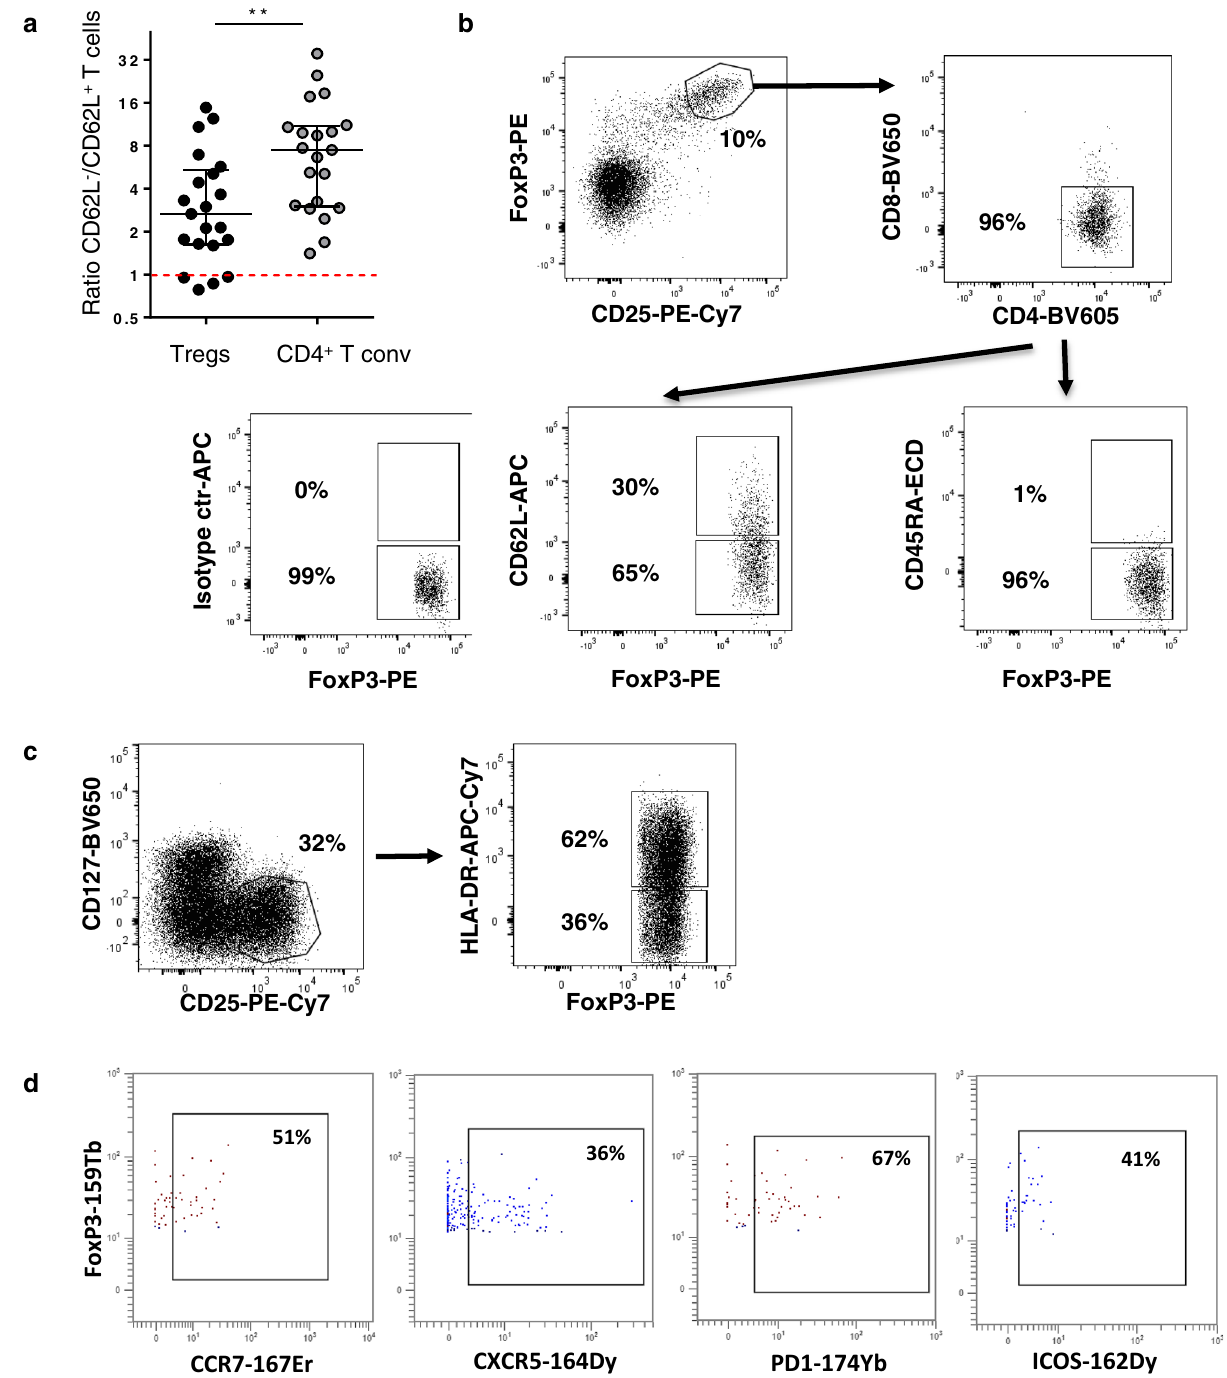
Fig. 2 Phenotype of Tregs in NSCLC. a Ratio of non-TLS to TLS CD3 + CD25 bright FoxP3 bright Tregs and CD4 + Tconv was determined according to the differential expression of CD62L ( n = 21 patients). Data are represented by median with interquartile range. Wilcoxon – Mann – Whitney U test; ** P = 0.0079. b , c Characterization of CD3 + CD25 bright FoxP3 bright cells according to CD4, CD8, CD62L, CD45RA, CD127, HLA-DR, and CD45ra expression by fl ow cytometry on fresh NSCLC tumors. d Illustration of the expression of CCR7, CXCR5, PD-1, and ICOS on CD3 + CD4 + CD8 − FoxP3 bright CD25 bright CD127 - CD62L + Tregs, and included co-stimulatory and inhibitory molecules (e.g., other anatomical sites. Therefore, the expression of 120 genes was 4-1BB, OX-40, BTLA, PD1, GITR, PD-L1, Tim-3, B7-H3 , and compared in Tregs in fi ltrating tumors, NTDL, LN, and blood samples from NSCLC patients. The most important number of genes differentially expressed was observed on Tregs isolated from tumors versus blood samples (Fig. 4a, Supplementary Fig. 4). Most of them were overexpressed in tumor-in fi ltrating